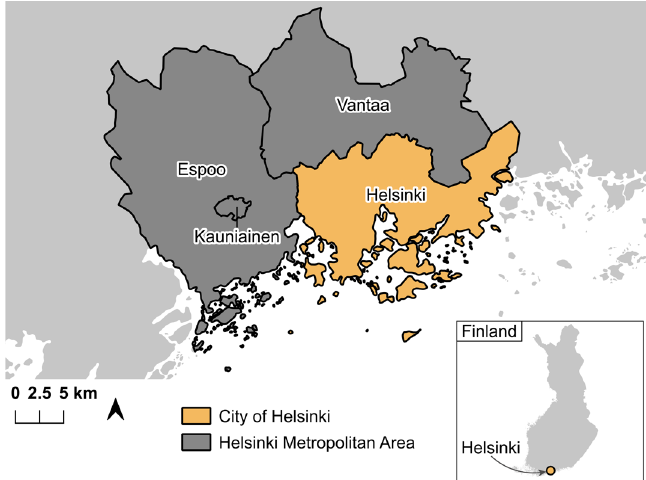
Fig. 1. City of Helsinki location in relation to Finland.